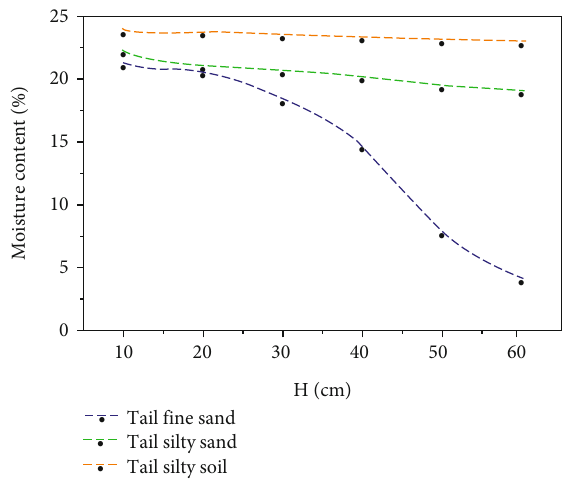
Figure 10: Relationship between moisture content and capillary